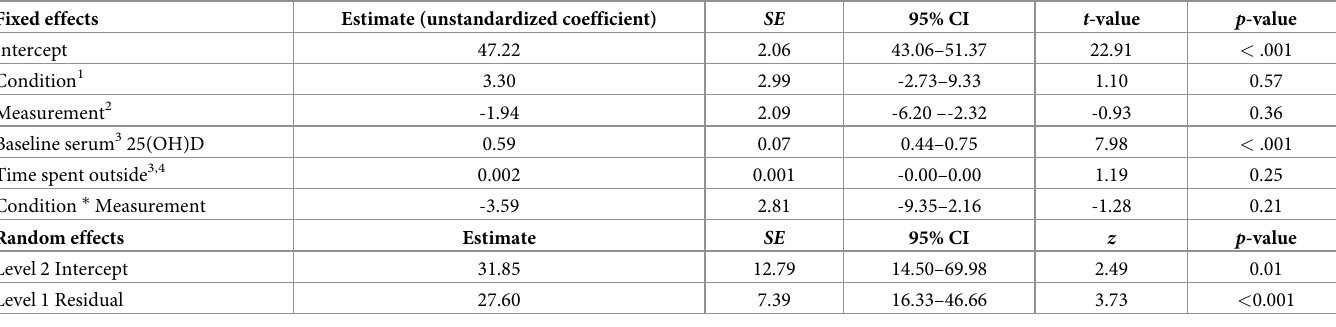
Table 6. Statistics linear mixed model analysis; effect of the intervention and measurement on serum 25(OH)D measured in Week 4 and Week 8.